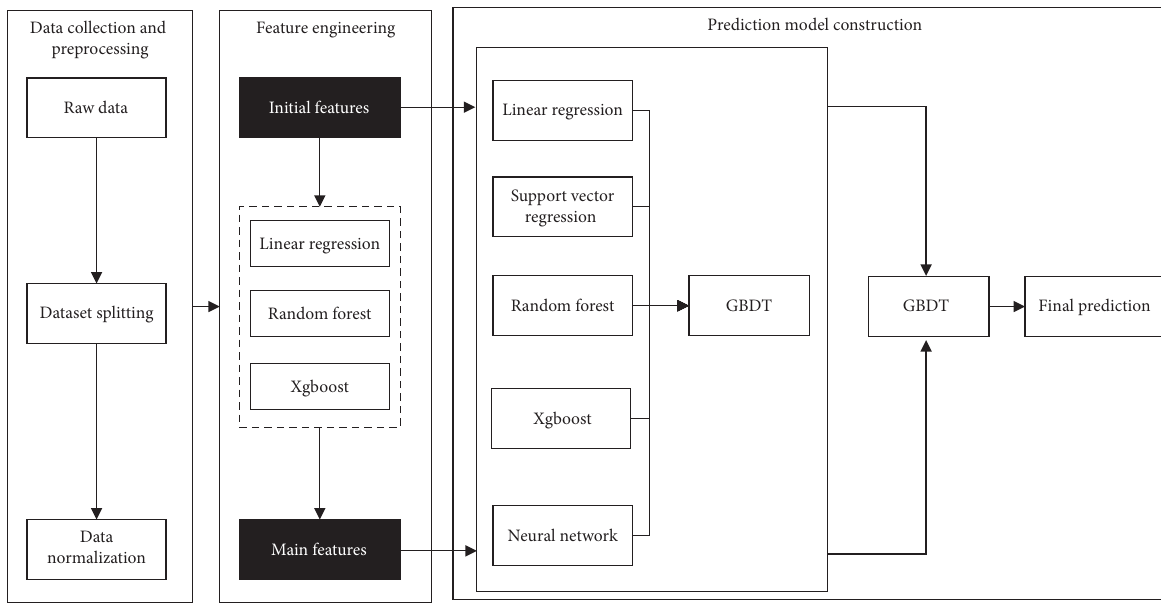
Figure 2: Flowchart for the proposed predicting